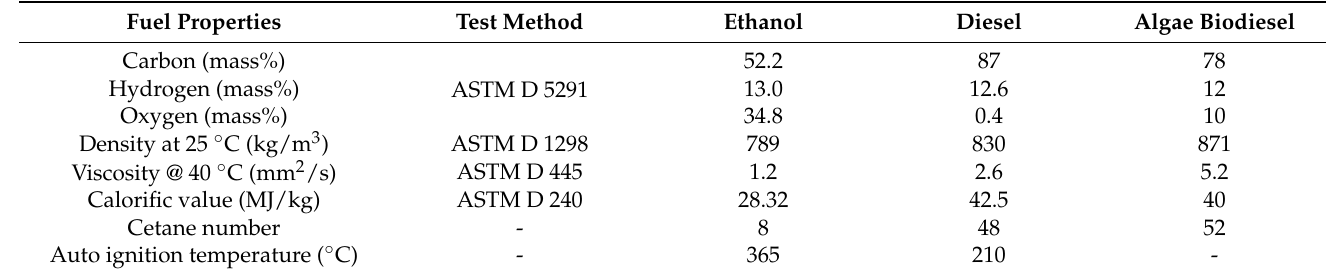
Table 1. Physicochemical properties of diesel, ethanol and algae biodiesel fuel.